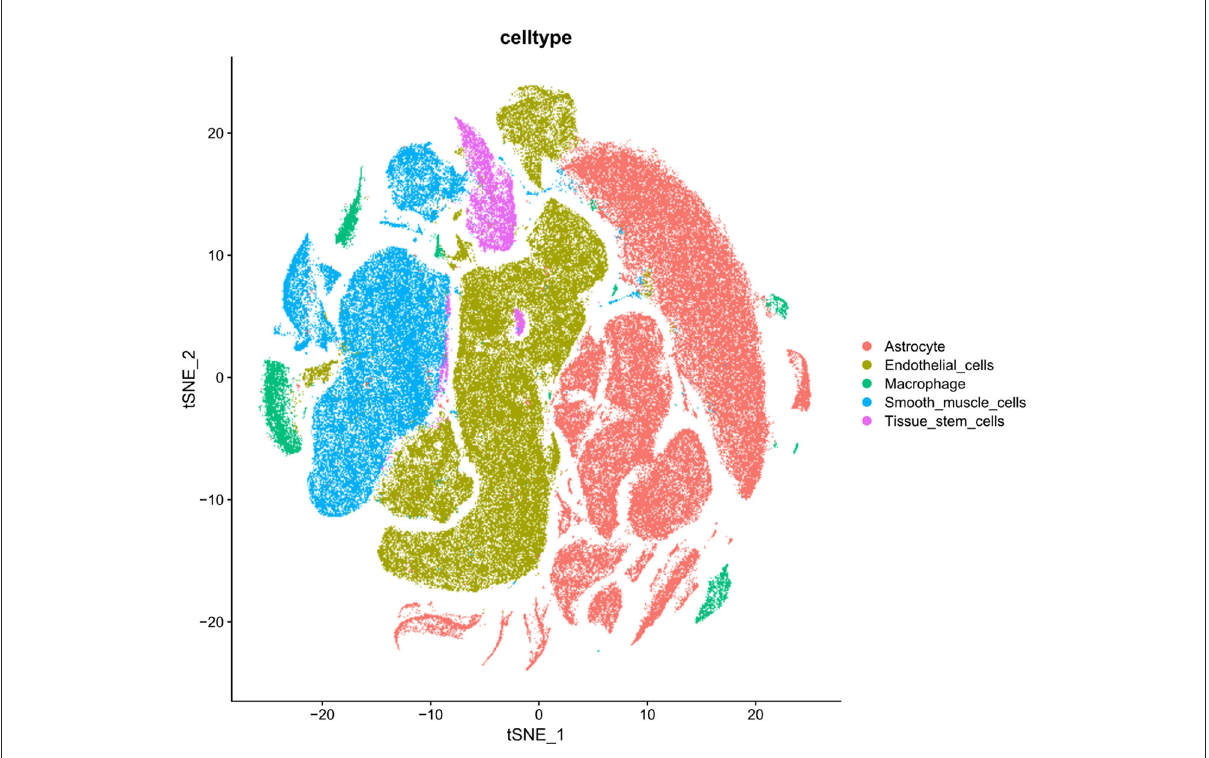
FIGURE2 Annotated distribution maps of cells in tSNE